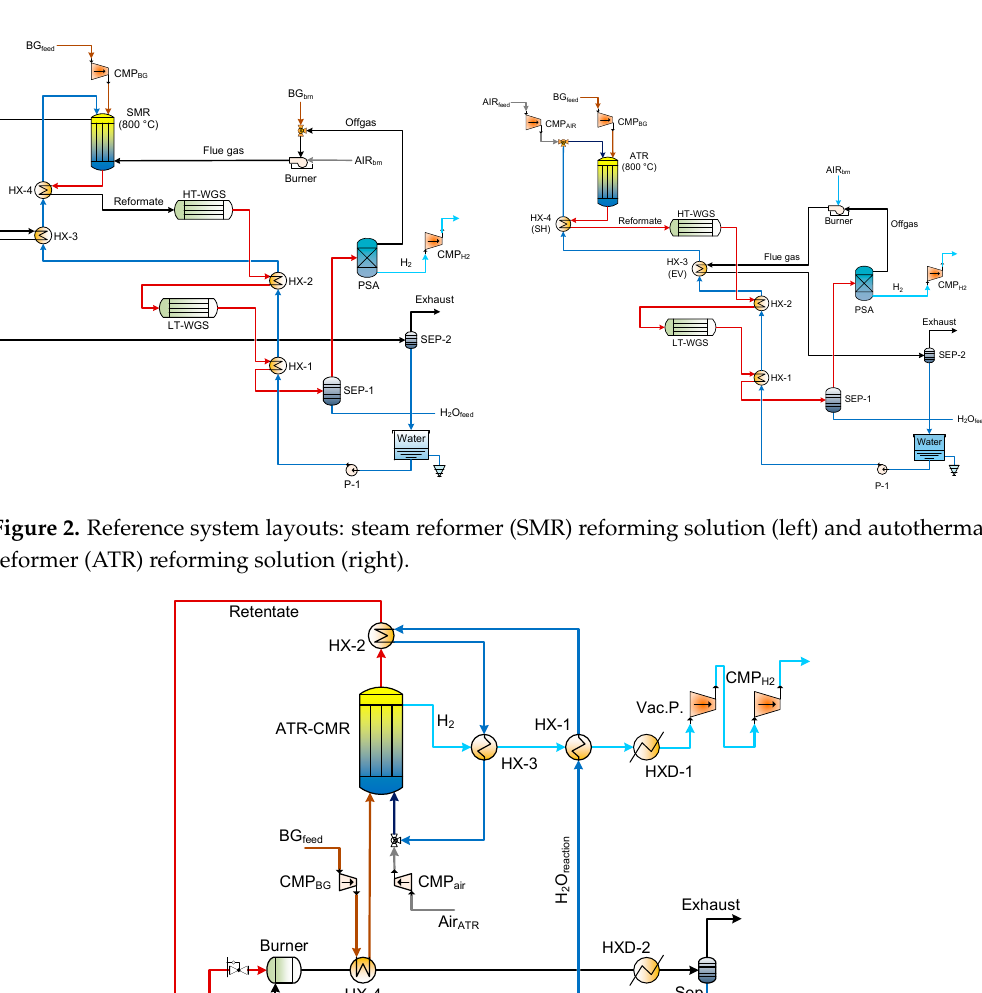
Figure 2. Reference system layouts: steam reformer (SMR) reforming solution (left) and autothermal reformer (ATR) reforming solution (right).